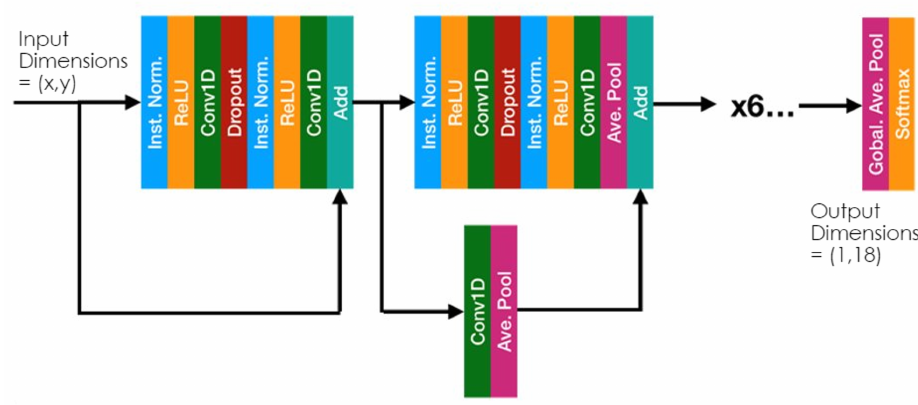
Figure 1. ResNet architecture for UCE device